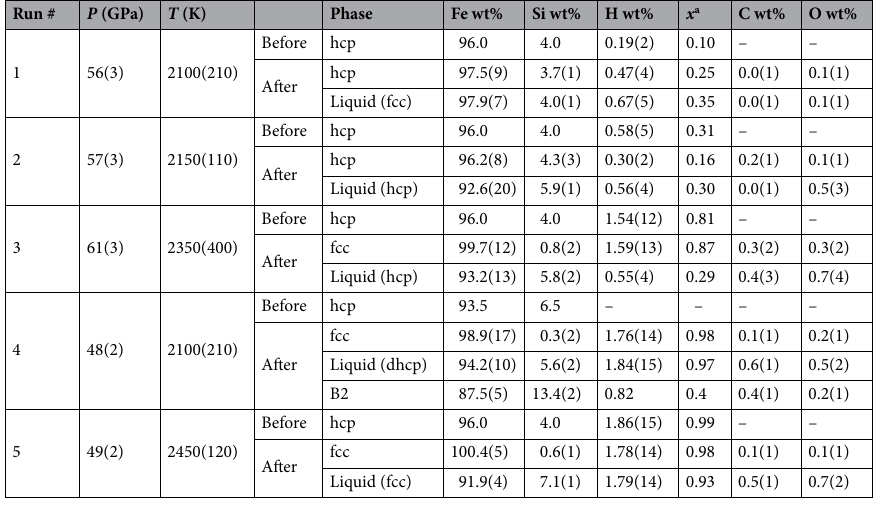
Table 1. Experimental conditions and results. Phases found before and after heating are given with their chemical compositions. The metal starting materials were Fe + 6.5 wt%Si in run #4 and Fe + 4.0 wt%Si in other runs. Numbers in parentheses indicate errors in the last digits. a x in (Fe,Si)H x